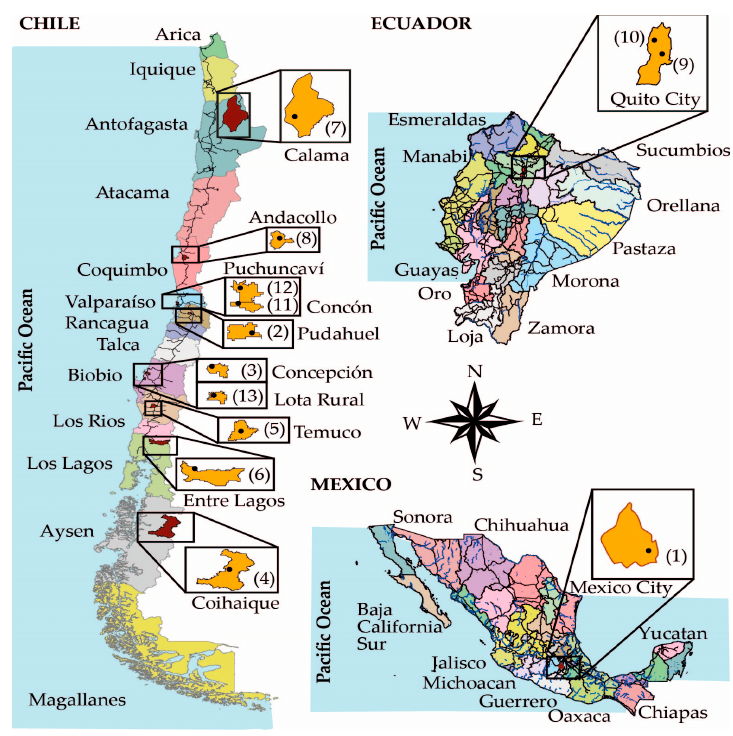
Figure 7. Study countries and locations.